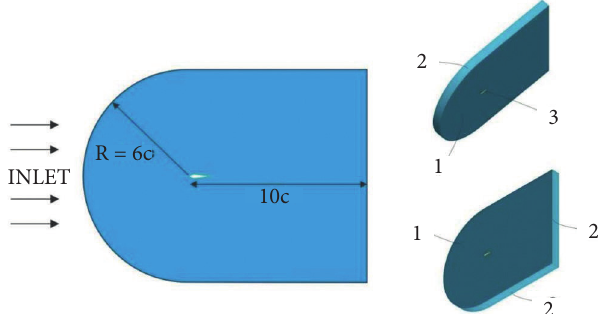
Figure 2. Computational domain and boundary conditions.